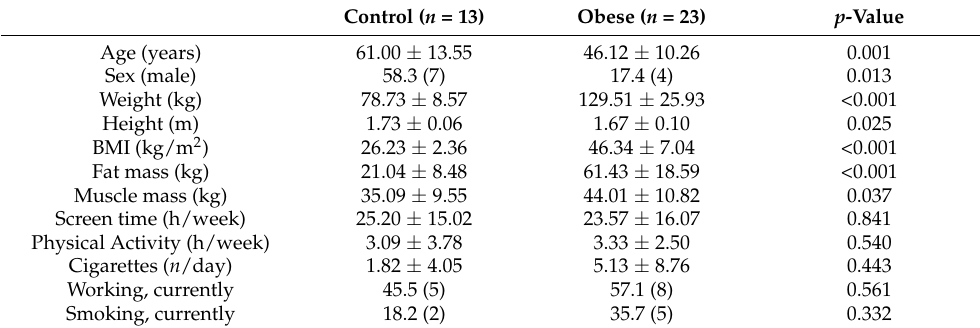
Table 1. Participant